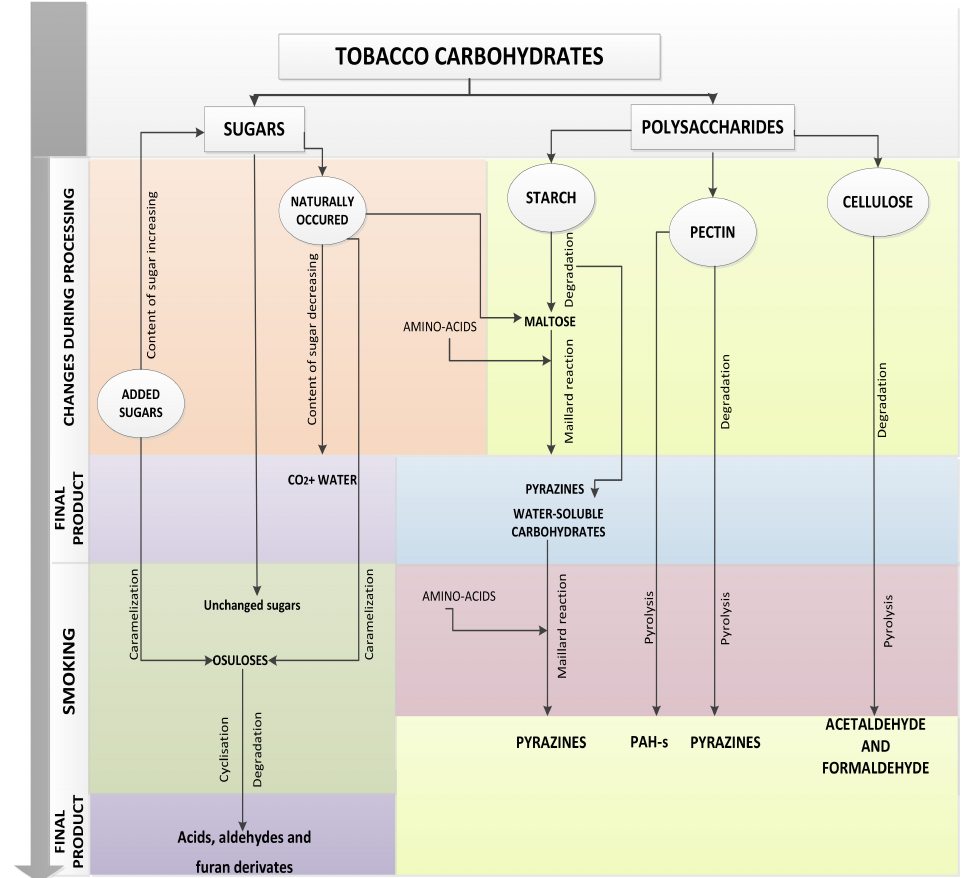
Figure 1. Changes in carbohydrates during tobacco processing and